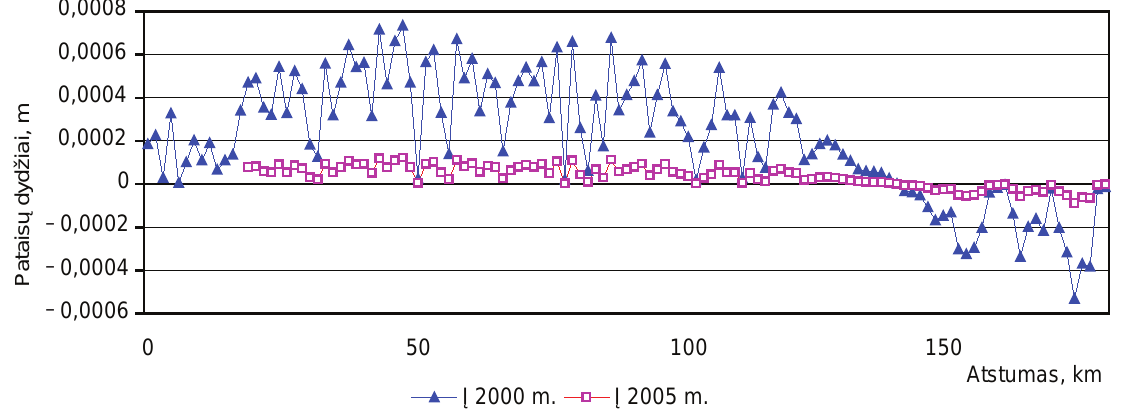
Fig. 2. Corrections to the levelling line Turmantas – Vilnius to reduce differences in the measured altitudes considering the selected time moment (2000,